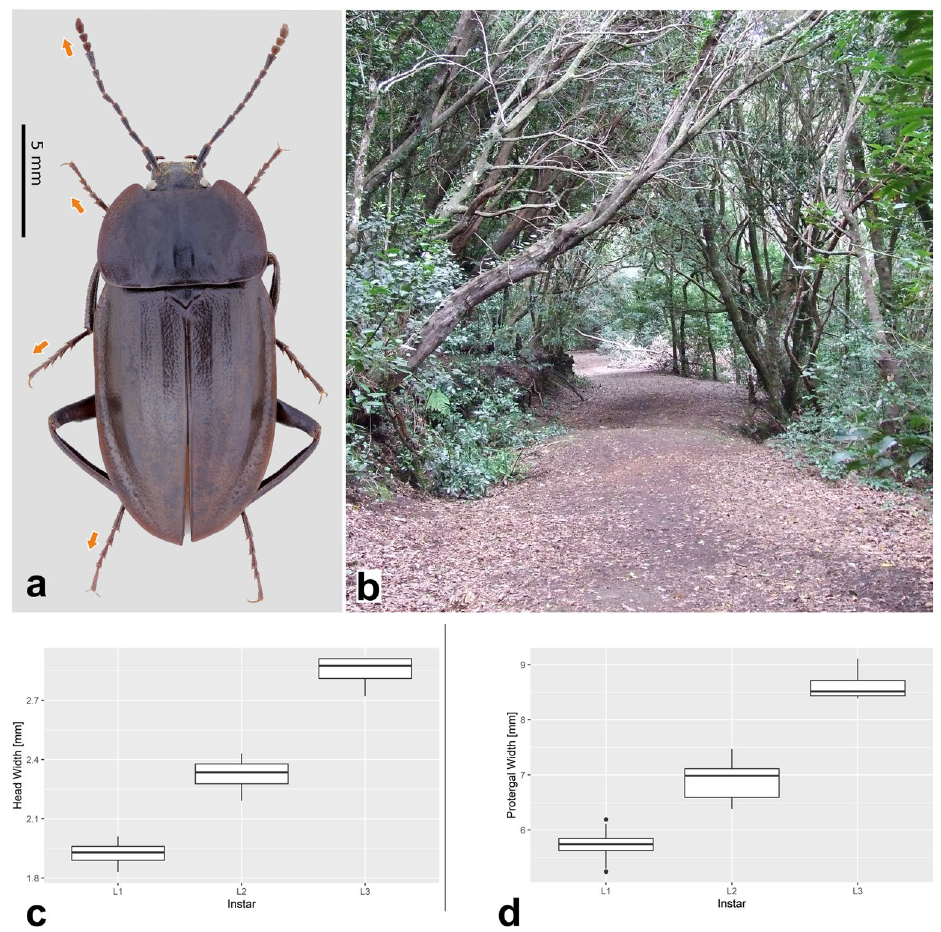
Figure 2. Heterotemna tenuicornis (Brullé, 1836): ( a ) female adult, dorsal view, arrows indicate distinctly elongated appendages; ( b ) Anaga Mts., detailed habitat with laurel forest. Boxplots of measurements of all three larval instars: ( c ) head width; ( d ) protergum